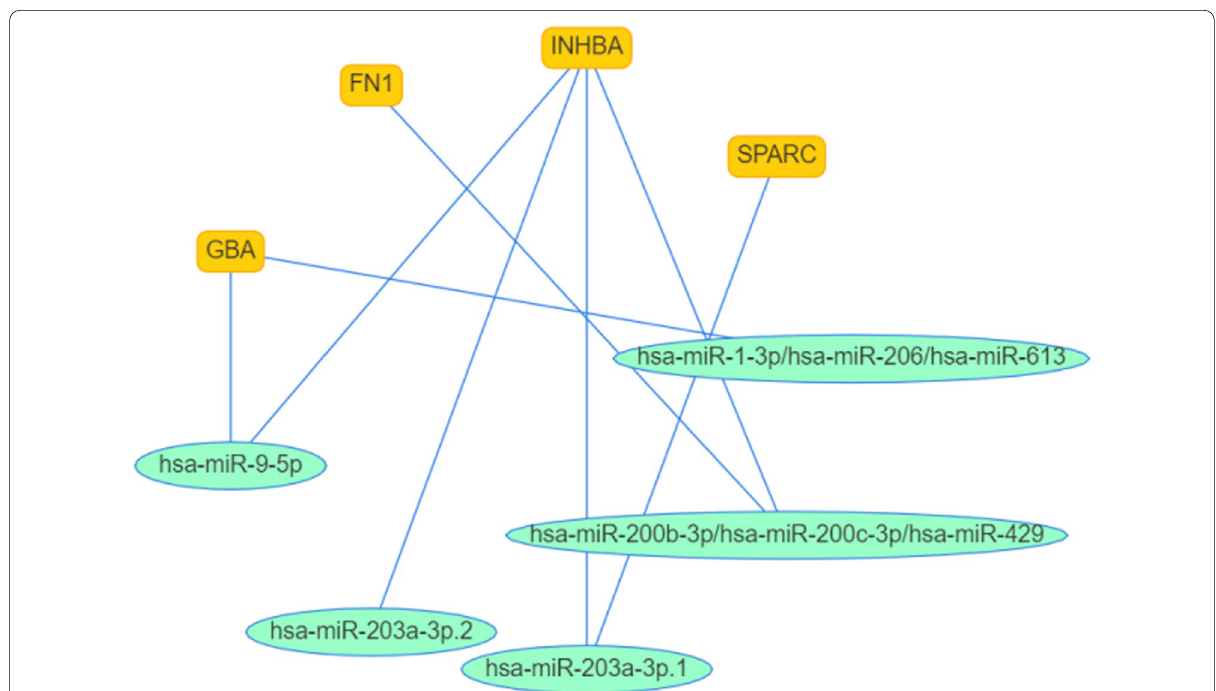
Fig. 6 Here, mapped important miRNAs and related candidate